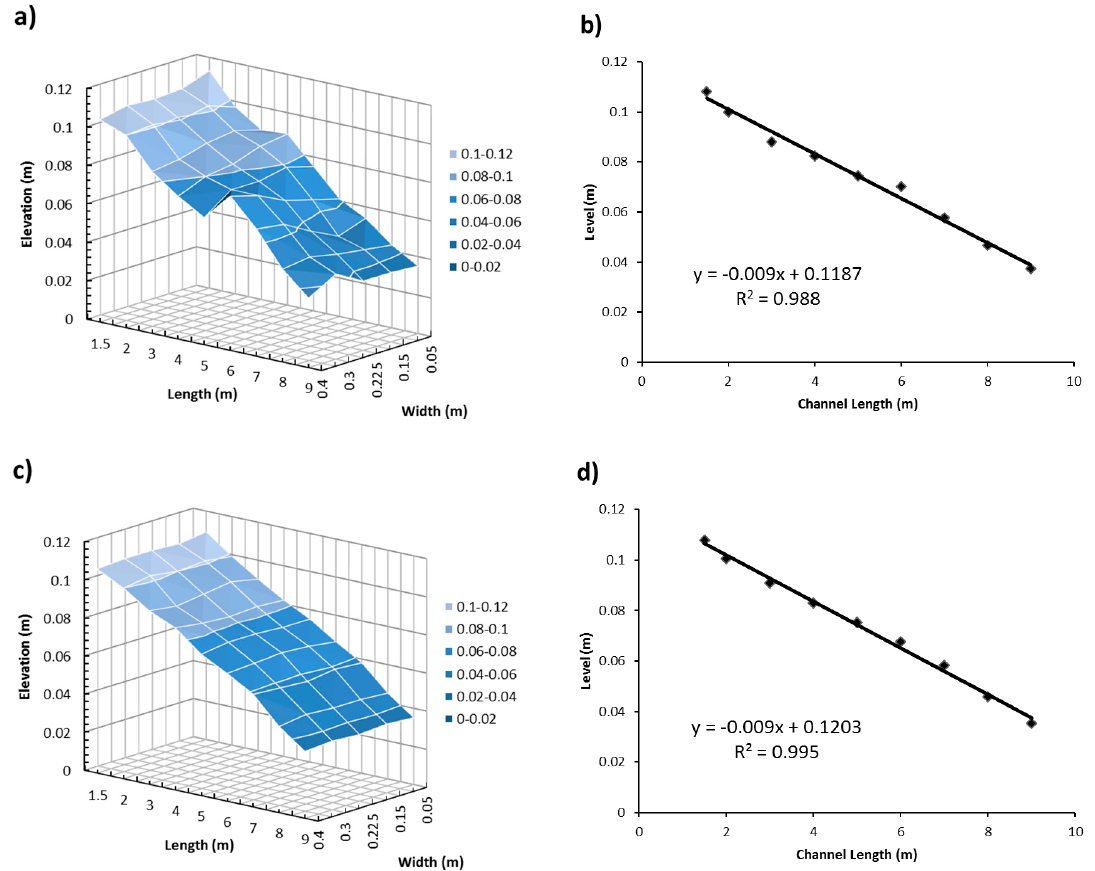
Figure 1. ( a ) 3D sediment elevation and ( b ) width-averaged sediment elevation measured for the water-worked bed; ( c ) 3D sediment elevation and ( d ) width-averaged sediment elevation measured for experimentally arranged rough bed.